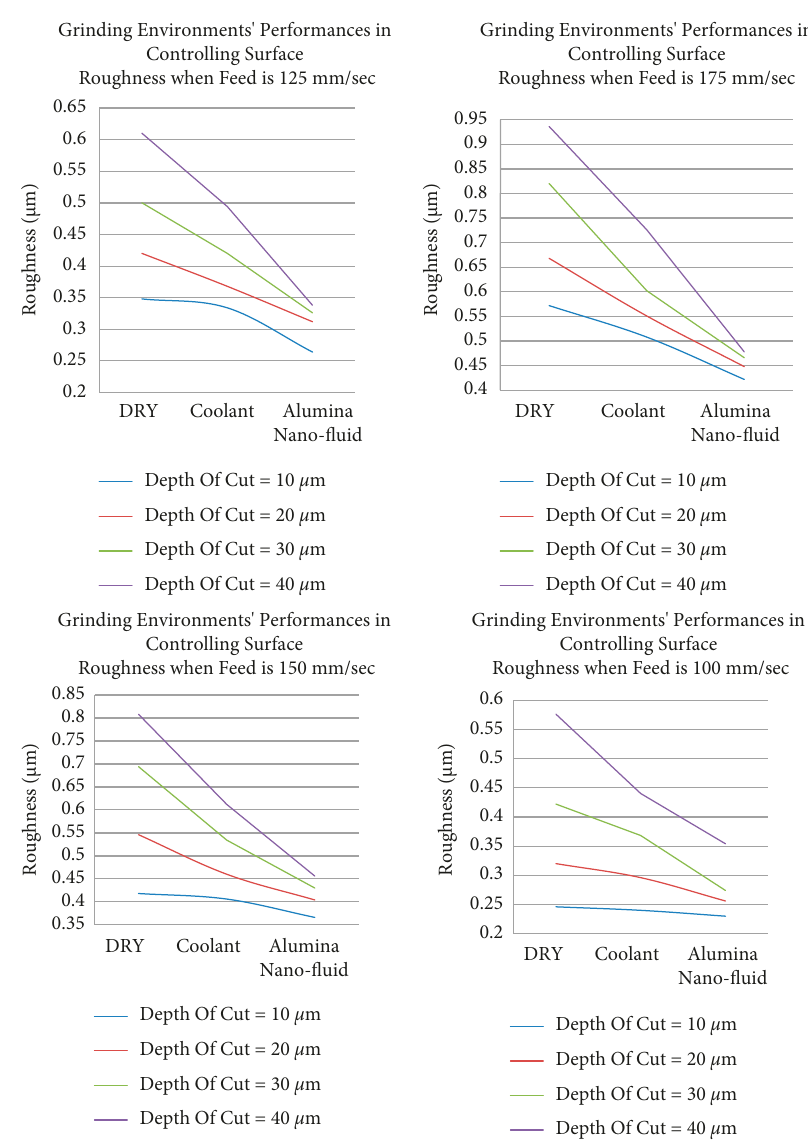
Figure 4: Grinding environments’ performances in controlling surface roughness at constant feed upgrading surface finish. Table 10: Surface roughness reduction by coolant and lubricant at constant